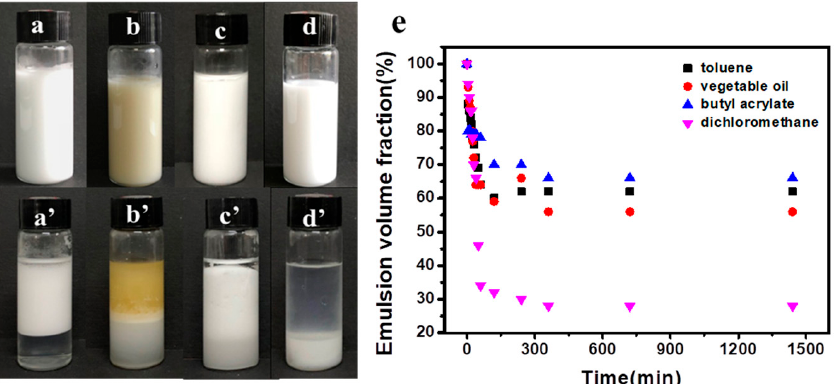
Figure 5. Appearance of Pickering emulsion stabilized by modified CNCs standing for 0 h ( a – d ) and 24 h ( a’ – d’ ) in various oil dispersion: ( a , a’ ) toluene, ( b , b’ ) vegetable oil, ( c , c’ ) butyl acrylate, ( d , d’ ) dichloromethane, and ( e ) their emulsion volume fraction. The concentration of modified CNCs was fixed at 0.3% ( w / v ). The oil/water ratio was 1:1.